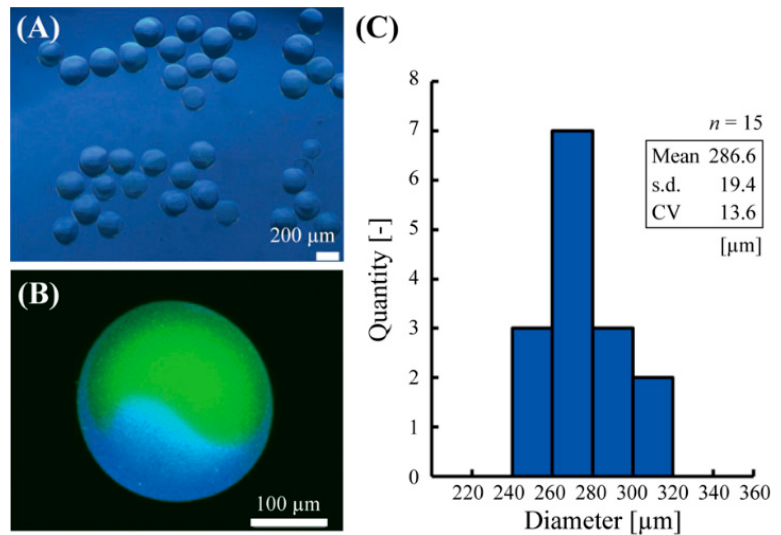
Figure 3. Fabricated Janus hydrogel microbeads. ( A ) A phase-contrast microscopic image of the microbeads. ( B ) A confocal fluorescent microscopic image of the microbeads. ( C ) Diameter distribution of the fabricated microbeads.